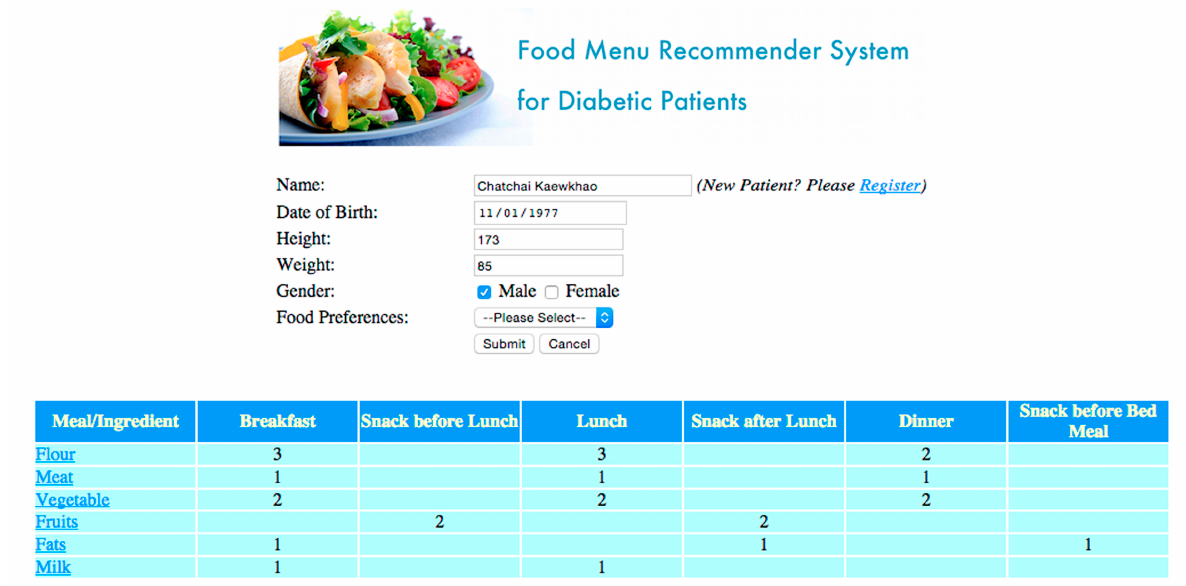
Figure 5. Screenshot for a registered patient accessing the Food Menu Recommender System and getting the basic recommendations on the intake of flour, meat, vegetables, fruits, fats and milk